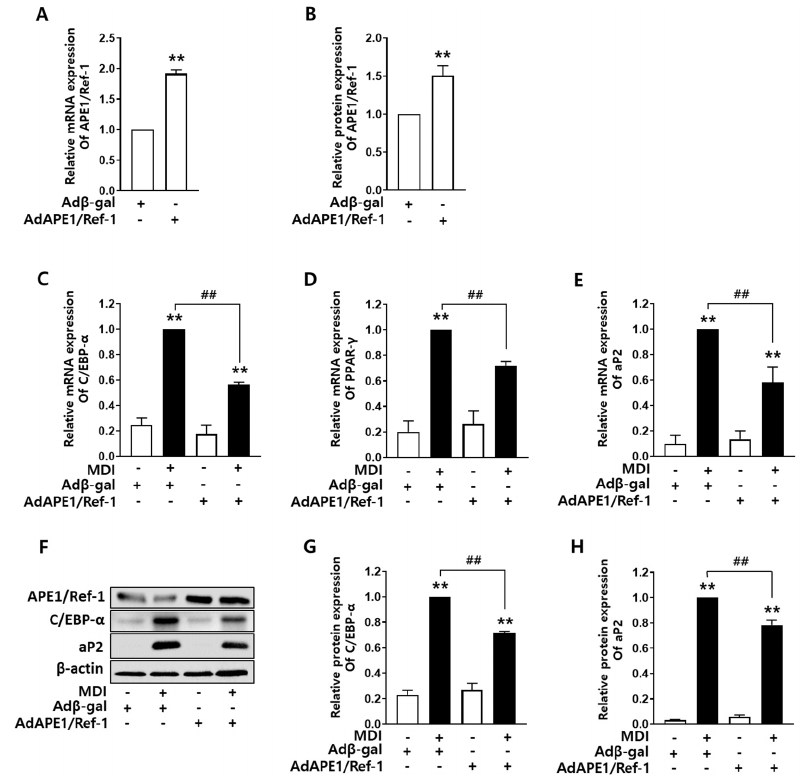
Figure 2. Overexpression of APE1/Ref-1 reduced adipocyte differentiation of 3T3-L1 cells. ( A , B ) 3T3- L1 cells infected with adenovirus expressing APE1/Ref-1 (AdAPE1/Ref-1) showed increased mRNA and protein levels of APE1/Ref-1 . ( C – E ) The mRNA levels of C/EBP- α , PPAR- γ , and aP2 were de- creased in APE1/Ref-1 -overexpresed cells during differentiation. ( F ) Representative Western blotting results for APE1/Ref-1, C/EBP- α , and aP2 protein levels during the differentiation of APE1/Ref- 1 -overexpressed adipocytes. ( G , H ) C/EBP- α and aP2 were decreased in APE1/Ref-1 -overexpressed adipocytes during differentiation. The graph shows the average band intensity normalized to β -actin expression. The relative mRNA and protein levels of C/EBP- α , PPAR- γ , and aP2 were calculated com- pared with those in cells cultured in MDI alone. The data represent mean ± SEM ( n = 3); ** p < 0.01 vs. basal level; ## p < 0.01 vs. MDI alone denotes statistically significant differences using the one-way ANOVA followed by Bonferroni’s multiple comparison